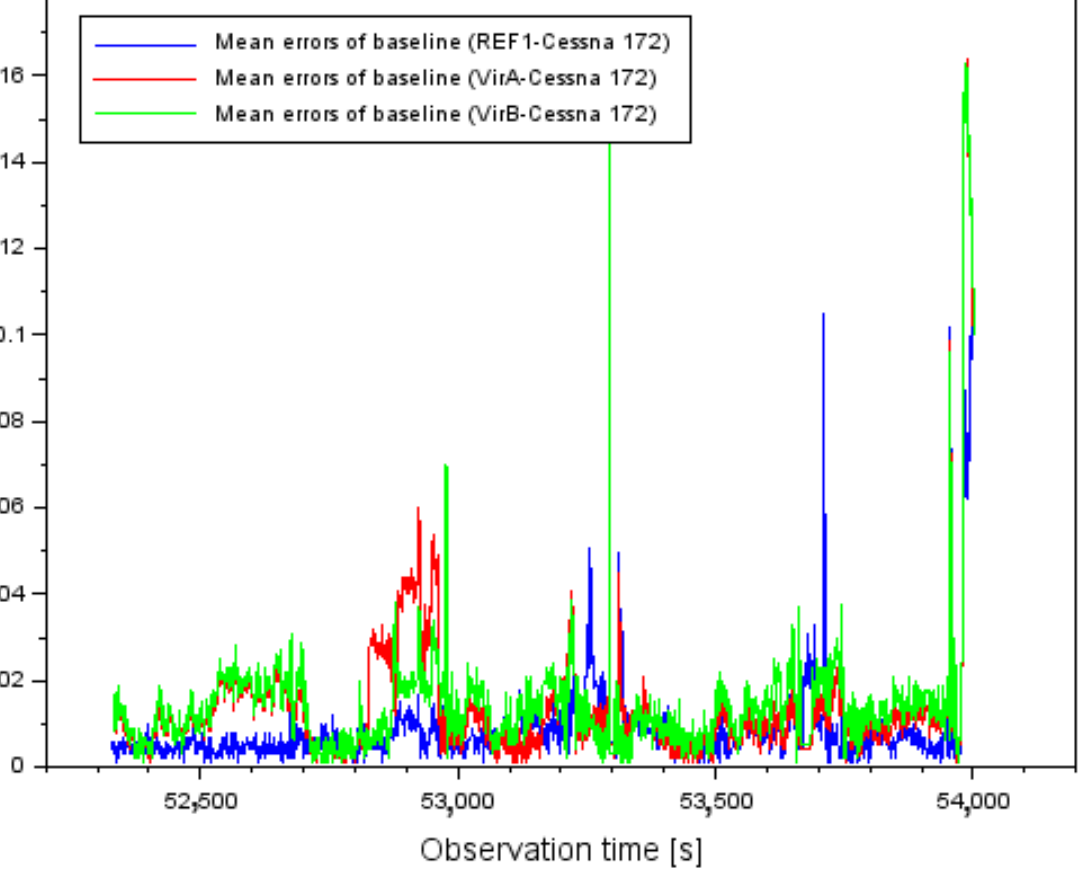
Figure 3. The values of PDOP for each baseline.